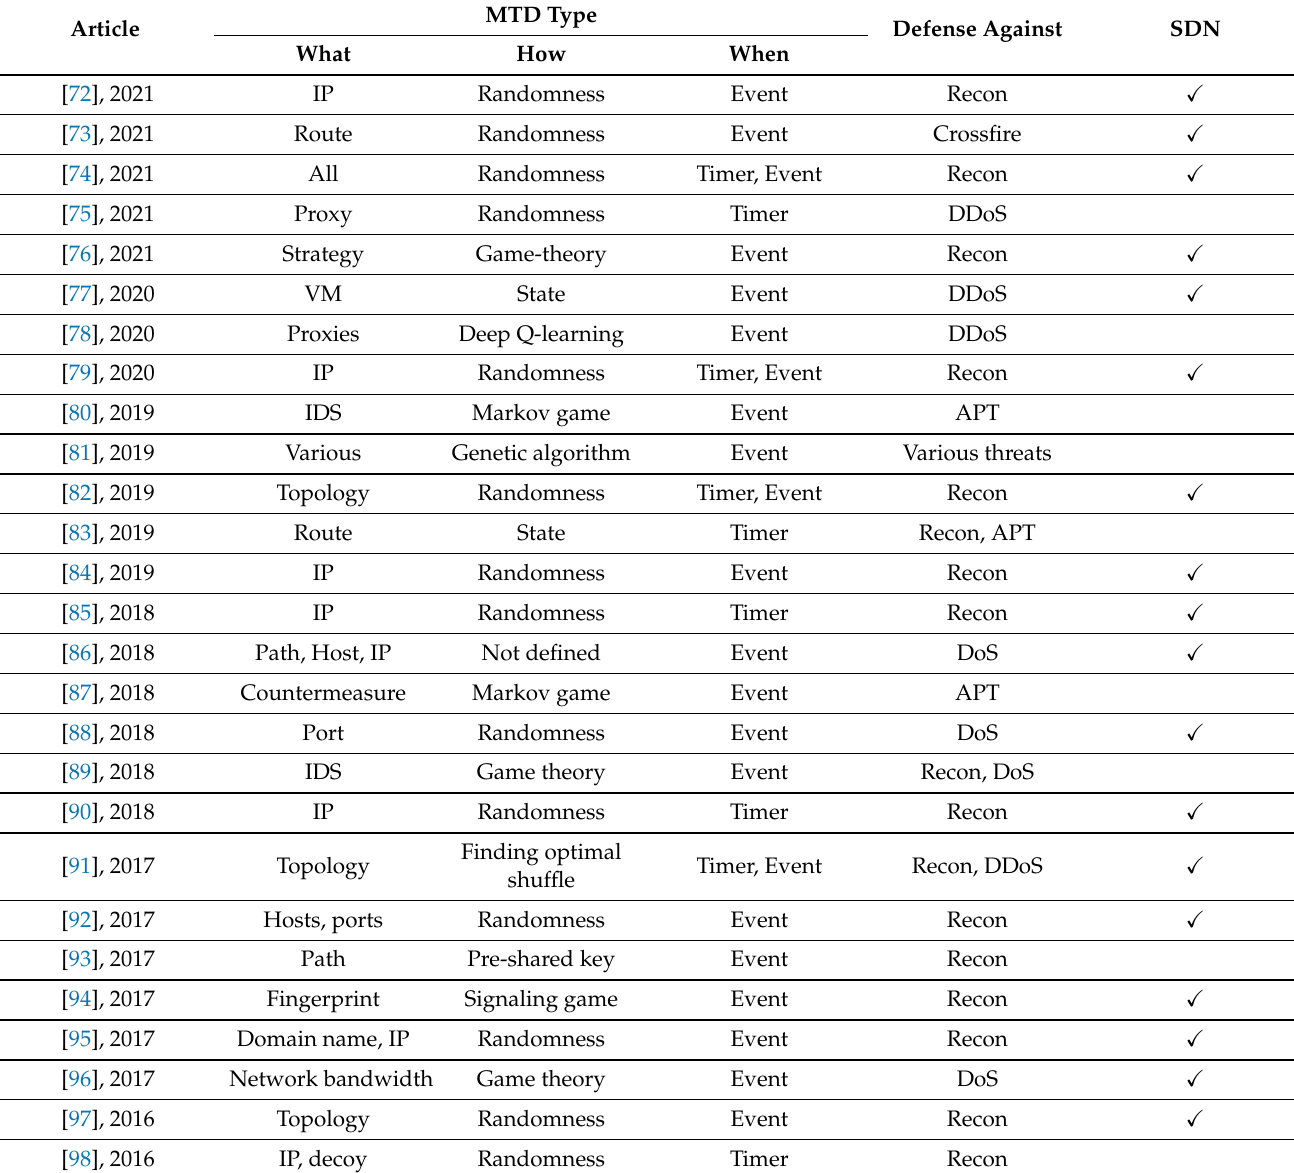
Table 1. A taxonomy of surveyed MTD architectures, covering the what, how, and when aspects of the MTD strategy used, attack types they prevent, and whether they are